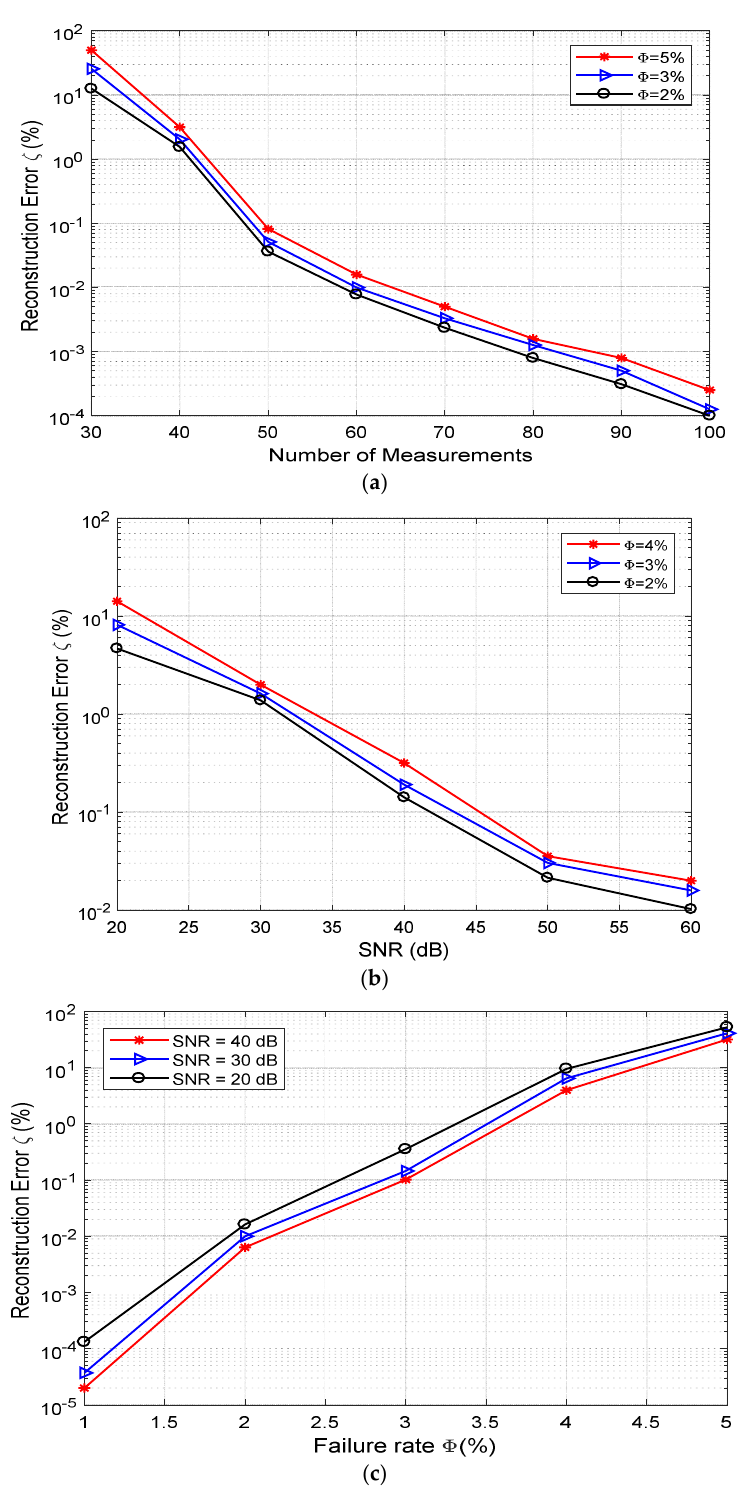
Figure 21. Experimental performance assessment of the proposed BCS-based diagnostic procedure. ( a ) Reconstruction error versus number of measurements, ( b ) Reconstruction error against SNR, ( c ) Reconstruction error with different failure